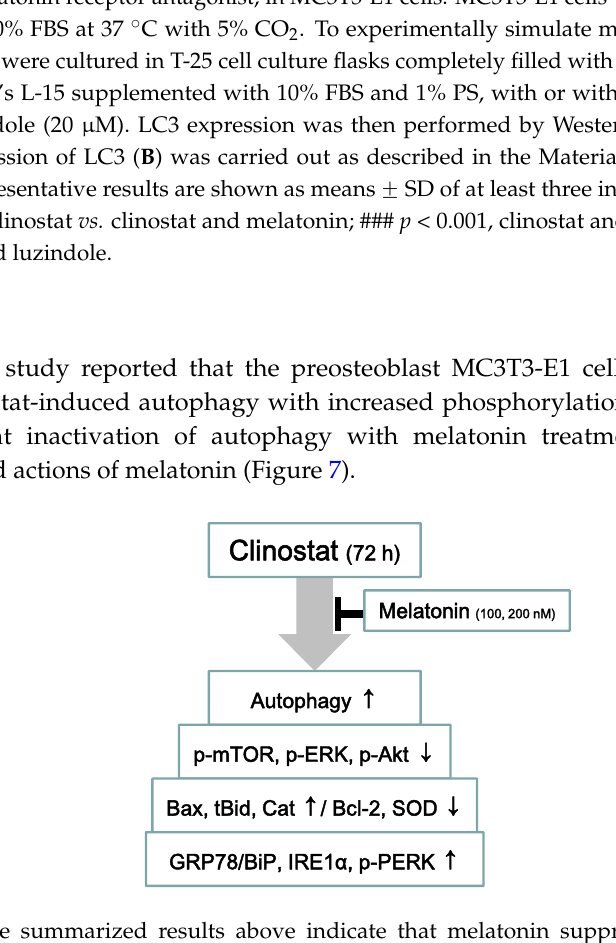
Figure 7. The summarized results above indicate that melatonin suppresses clinostat-induced autophagy through increasing the phosphorylation of the ERK/Akt/mTOR proteins. ↑ , Activation or increase of protein level; ↓ , Decrease of protein level; ├ , Inhibition or suppression.